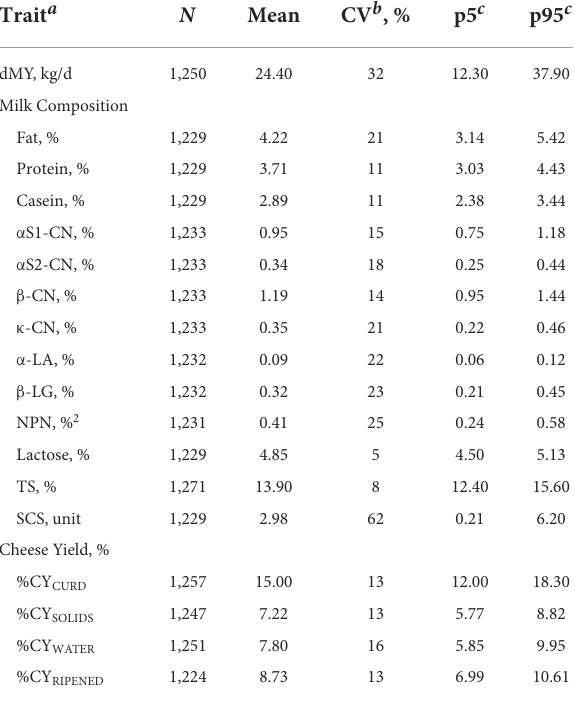
TABLE 1 Descriptive statistics of daily milk yield, milk components (gross composition, somatic cell score and protein fractions) and cheese